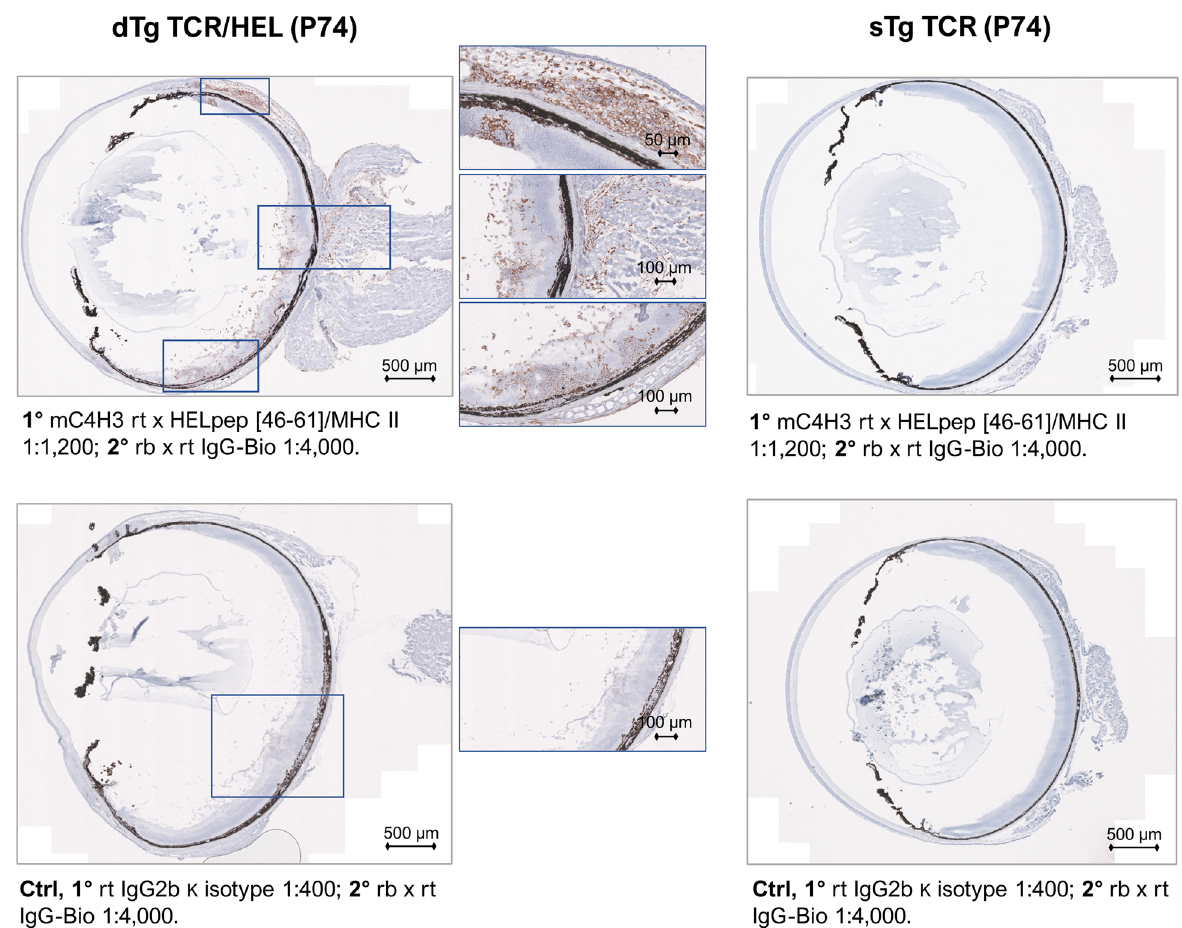
Figure 4. MHCII-HEL complexes are exclusively present in retinas of dTg mice. The monoclonal C4H3 rat anti-chicken antibody towards HEL peptide [46–61] was used to stain MHCII-HEL complexes in eye sections. OCT sections were counterstained with Haematoxylin QS (Vector Laboratories, 2BScientific, UK). Left panel: P74 section from dTg mouse; note positive brown staining particularly in and around inflamed retinal tissue and uveal tract vs. control (faint background only). Right panel: staining was performed using sTg TCR eye sections. No staining was found in either sTg TCR test conditions. Per genotype group n = 3 sections were independently stained across three